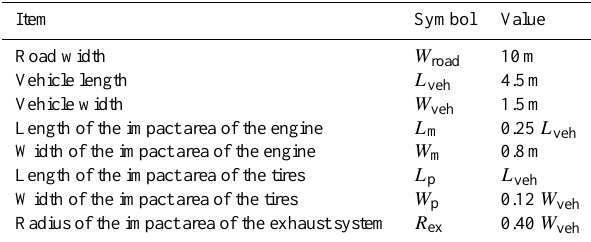
Table 1. Dimensions of the vehicle impact zone. Item Symbol Value Road